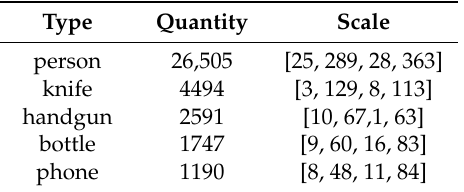
Table 1. The composition of Terahertz Human Dataset.